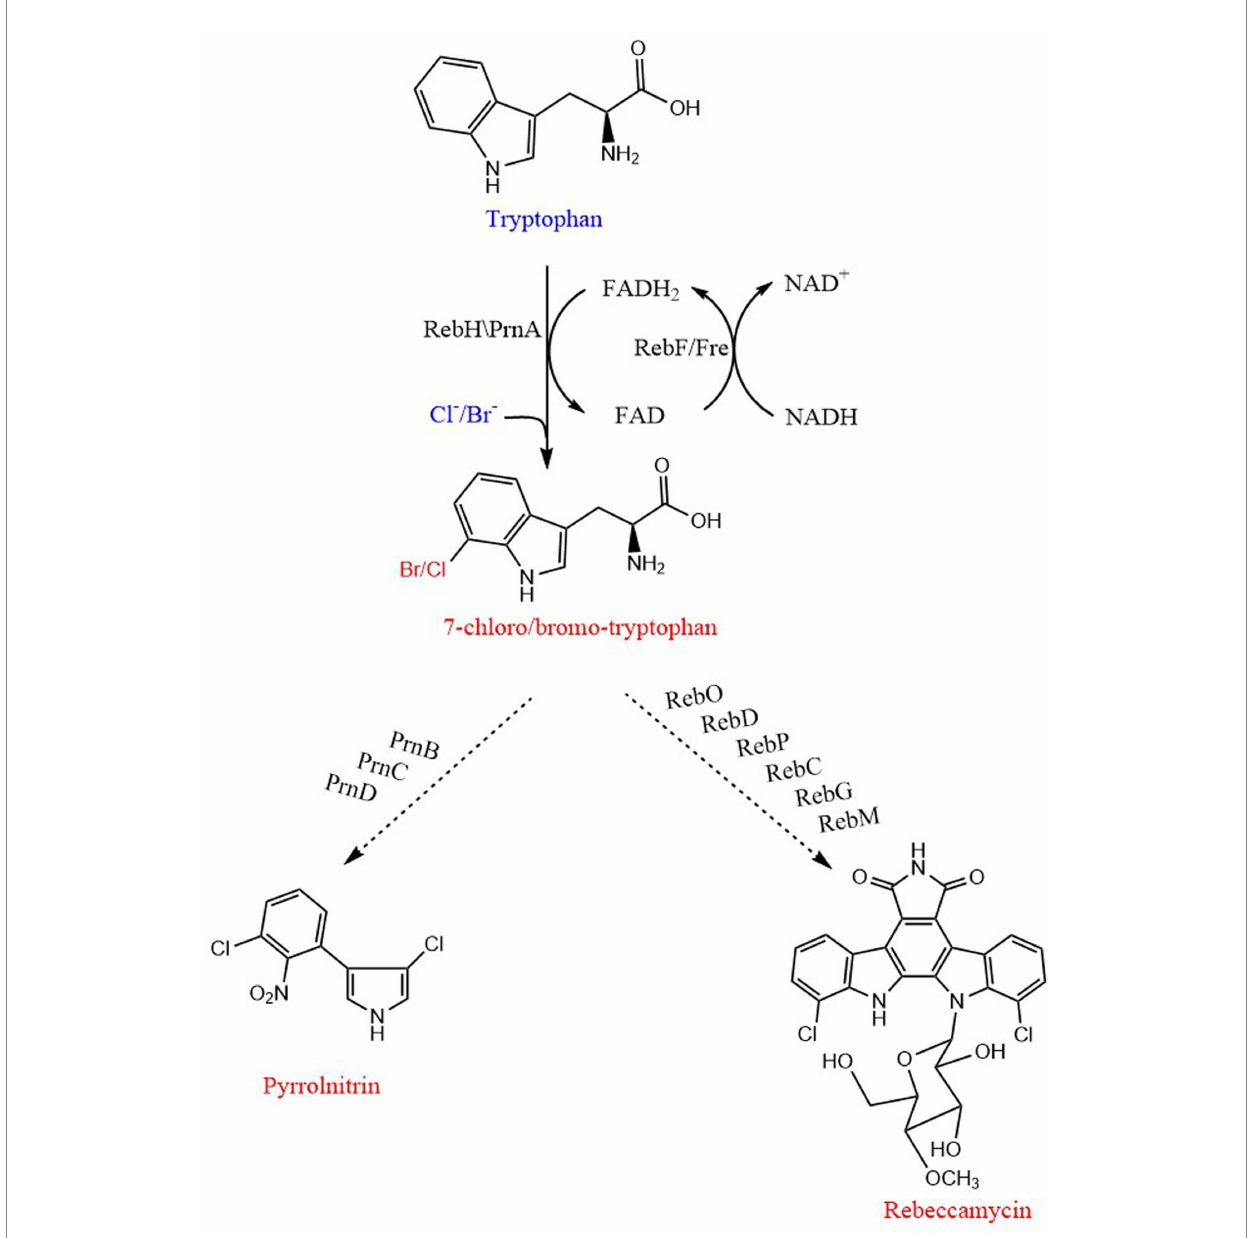
FIGURE 7 Biosynthetic pathway of 7-Halo-tryptophan, pyrrolnitrin and rebeccamycin. PrnA and RebH are FAD-dependent halogenases. RebF and Fre are NADH- dependent flavin reductases. PrnB, monodechloroaminopyrrolnitrin synthase; PrnC, monodechloroaminopyrrolnitrin halogenase; PrnD, aminopyrrolnitrin oxygenase; RebD acts as both a catalase and a CPA synthase; RebO, FAD-dependent L-tryptophan oxidase; RebP, cytochrome P450 enzyme; RebC, monooxygenase; RebG, N-glycosyltransferase; RebM, methyltransferase. The order of action of enzymes is from top to bottom. The straight line and dotted line represent one-step and multi-step,